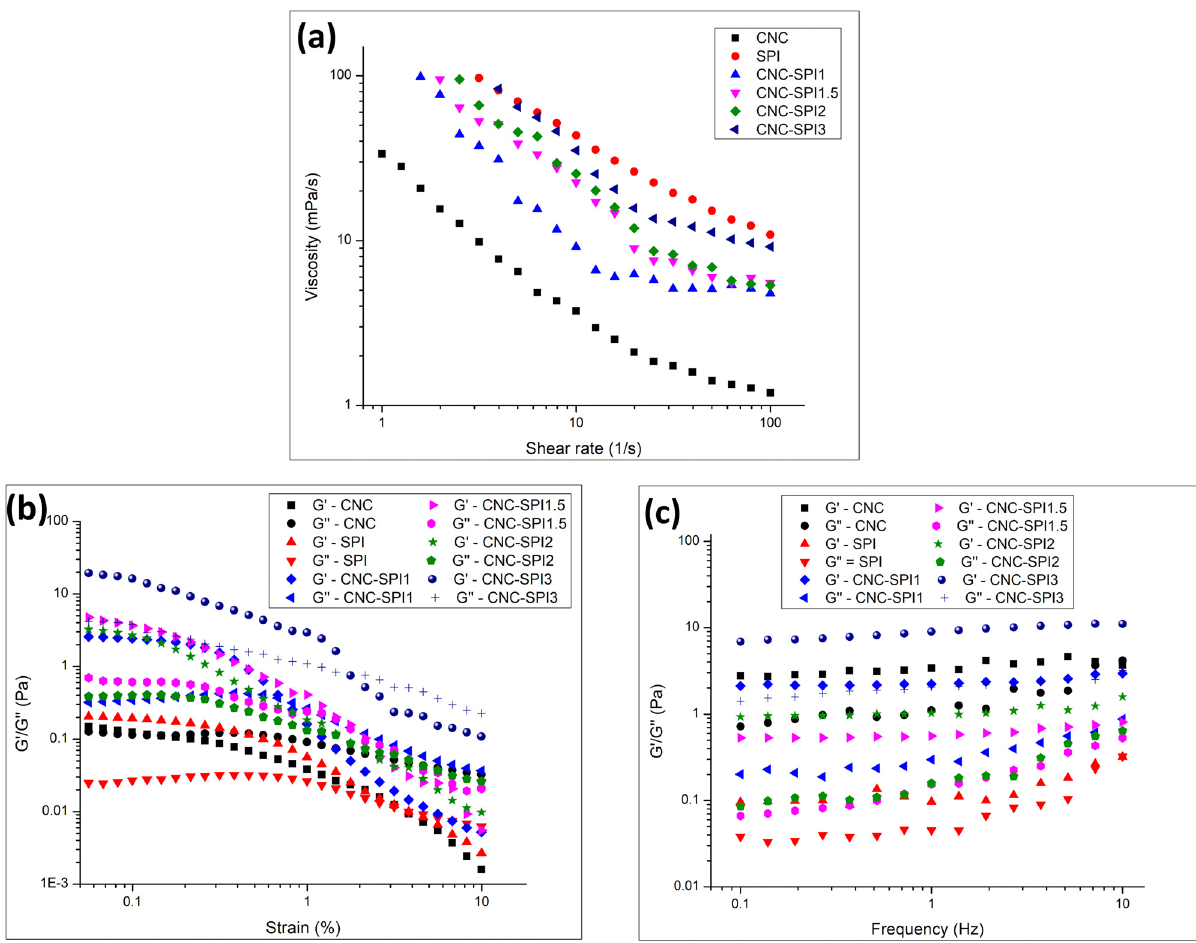
Figure 6: ( a ) Viscosity for the O/W emulsions stabilized by CNC, SPI, and CNC – SPI nanoconjugates as a function of shear rate. The G ′ and G ″ for the O/W emulsions stabilized by CNC, SPI, and CNC – SPI nanoconjugates as a function of ( b ) shear strain and ( c )